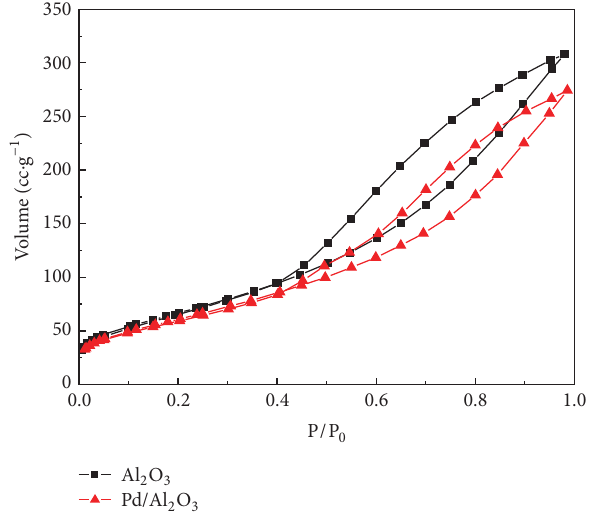
Figure 11: The N 2 adsorption-desorption isotherms of Al 2 O 3 and 1% Pd/Al 2 O 3 .